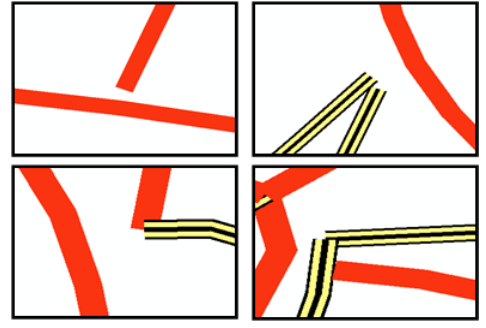
Figure 8: Examples of crossings and errors that was smoothed using Bezier’s Algorithm As final results, digitized road network map and the final generalized output map was compared (Figure 9). It is obvious that, final generalized output map looks more readable compared to the digitized map. Generalized map was also compared to the scanned “Topographic map of Uttaranchal 1:50 000, 53 J/3” as the target map was taken as this table (Table 1). Comparison of the roads and differences of them were checked.